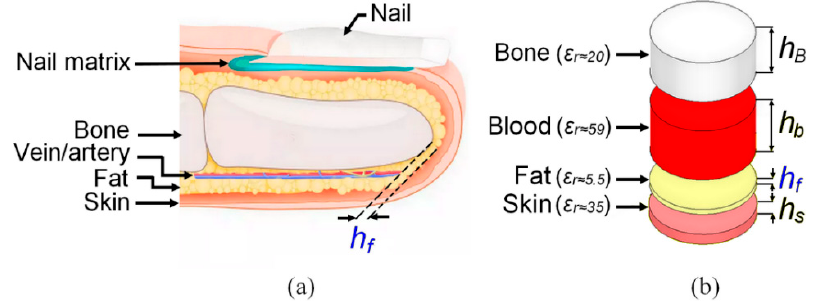
Figure 1. Anatomy of a human fingertip in ( a ) and the adopted Cole–Cole-based four-layers fingertip model in ( b ).